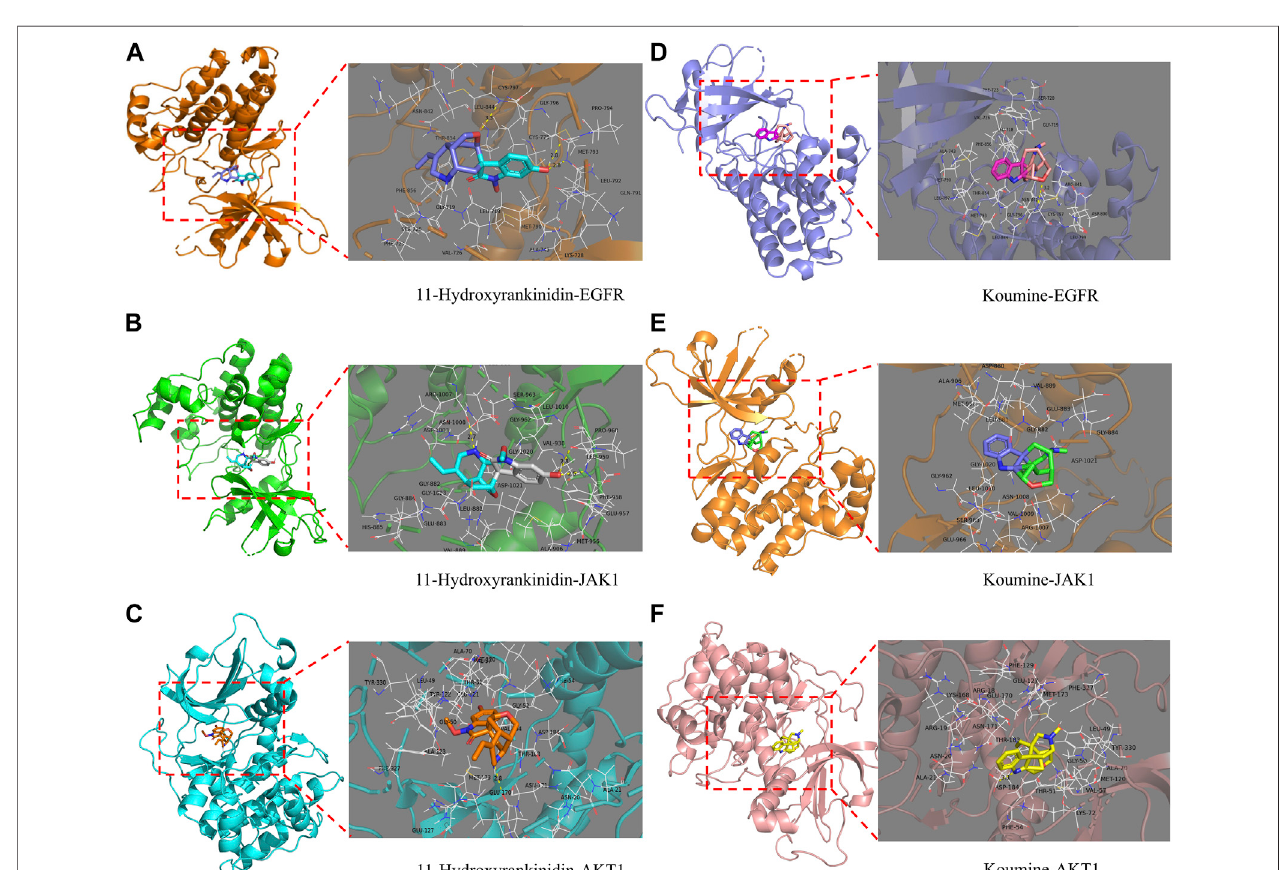
FIGURE 6 | Virtual docking of the binding of EGFR, JAK1, and AKT1 with 11-Hydroxyrankinidine (A – C) and koumine (D – F) shown as 3D diagrams.